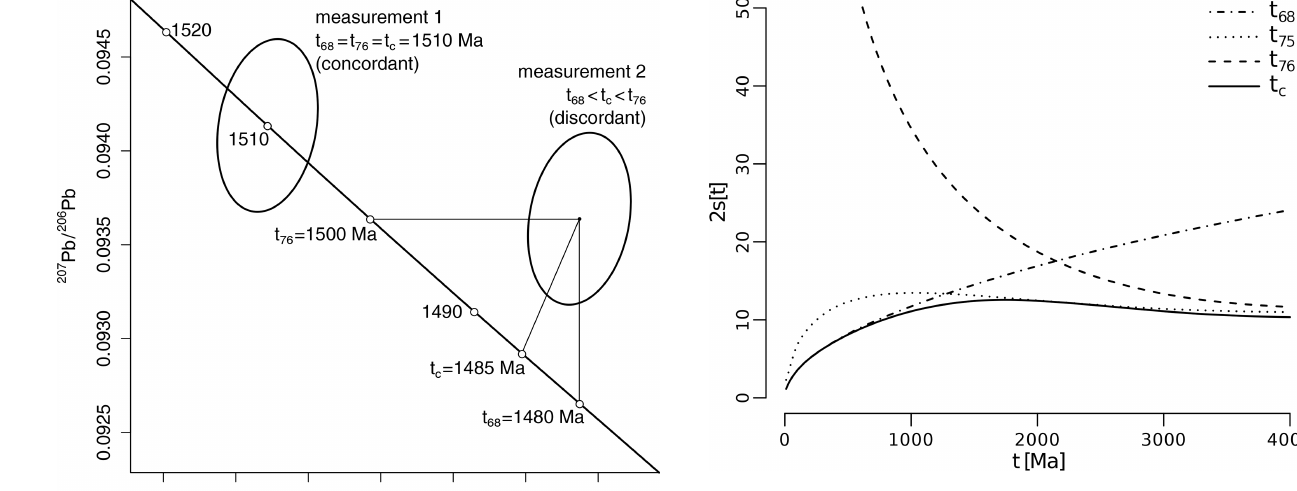
Figure 2. Predicted uncertainties of the 206 Pb / 238 U ( t 68 ), 207 Pb / 235 U ( t 207 Pb / 206 Pb ( t 75 ), 76 ), and concordia ( t c ) ages for a synthetic dataset with a constant uranium concentration. Dwell times and detector sensitivities were chosen so as to yield results that are similar to those obtained from real data. The concordia age (solid line) always offers the best precision. See Appendix A for further details about the calculations behind this